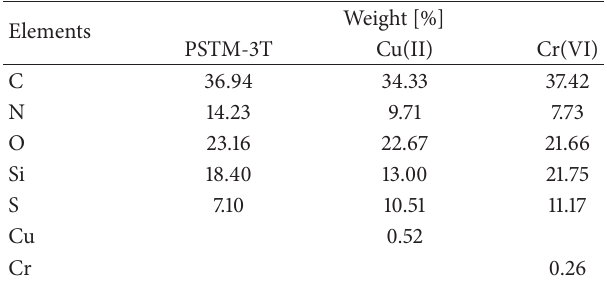
Table 1: Chemical composition of PSTM-3T and after treatment into ion solutions.